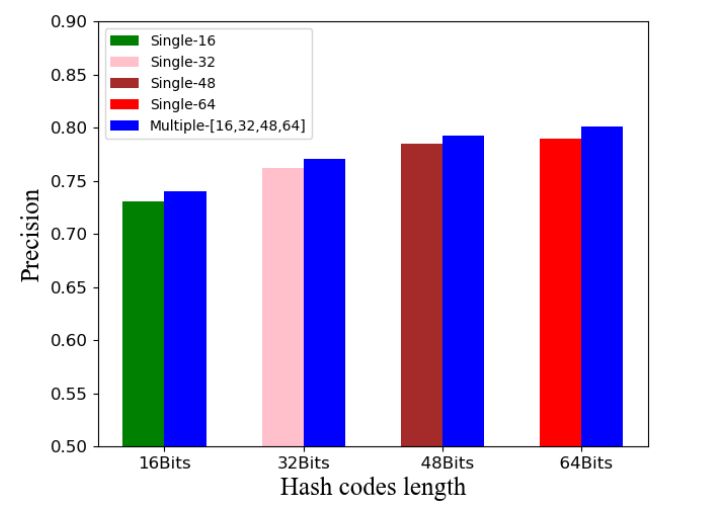
Figure 3. Multi-task learning ablation experiment on NUS-WIDE.